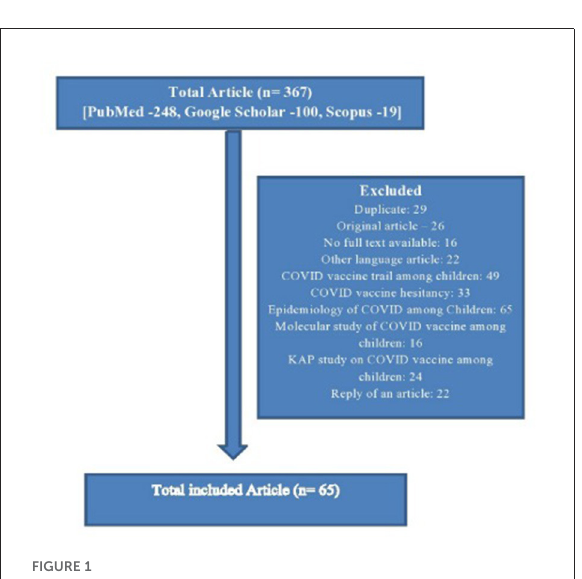
FIGURE1 Flow diagram of the review